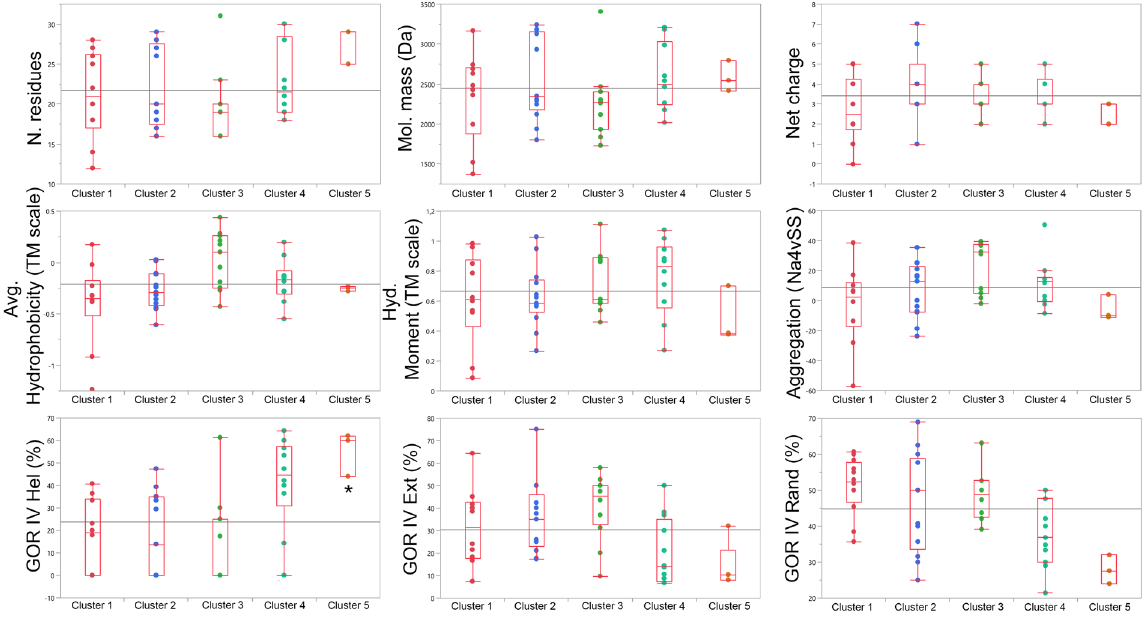
Figure 6. Box plot of peptide clusters and their corresponding physicochemical properties. The physicochemical properties of the extended set of peptides (Table 1, 2012 and 2016 sets) were calculated and plotted as a function of cluster memberships, as obtained from the PCA2 analysis. The residue number (N. residues), molecular mass (Mol. mass (Da)), net charge, average hydrophobicity (Avg. Hydrophobicity (TM scale) 1 , hydrophobic moment (Hyd. Moment (TM scale)), aggregation potential (Agreggation (Na4vSS)) 18 , and secondary structure according to the GOR IV algorithm 20 , (GOR IV Helical, GOR IV Extended and GOR IV rand) were determined. The Steel-Dwass all pairs statistical test was applied ( * p < 0.05). Please refer to Supplementary material 04 document for a complete description of statistical tests and their significances. Horizontal grey lines correspond to the grand